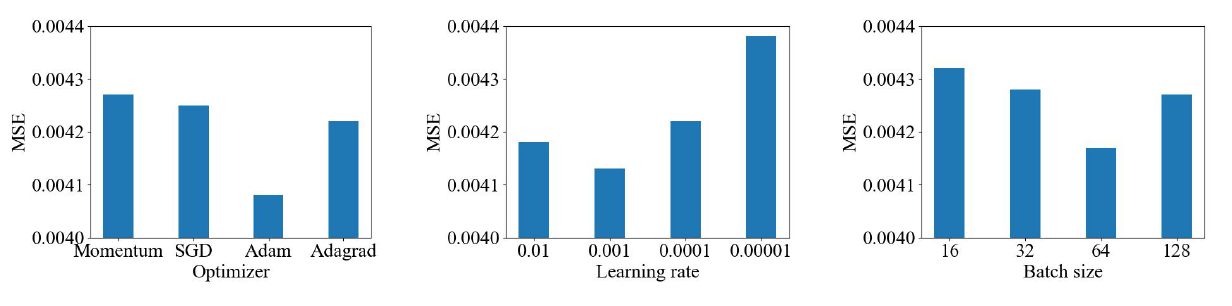
Figure 9. MSE of the proposed model under different hyperparameters.